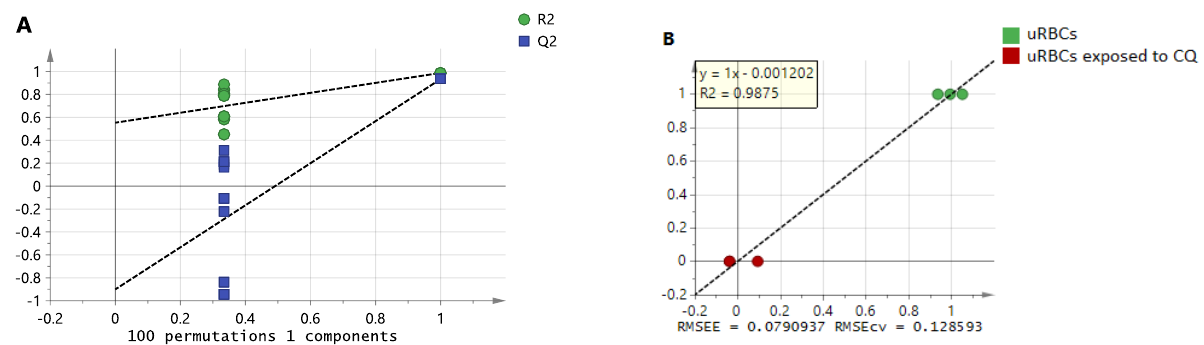
Figure 8. The OPLS-DA model’s validation of uRBCs-control and uRBCs-CQ: ( A ) 100 permutations test; ( B ) the validation regression plot. uRBCs, uninfected red blood cells; CQ, chloroquine.